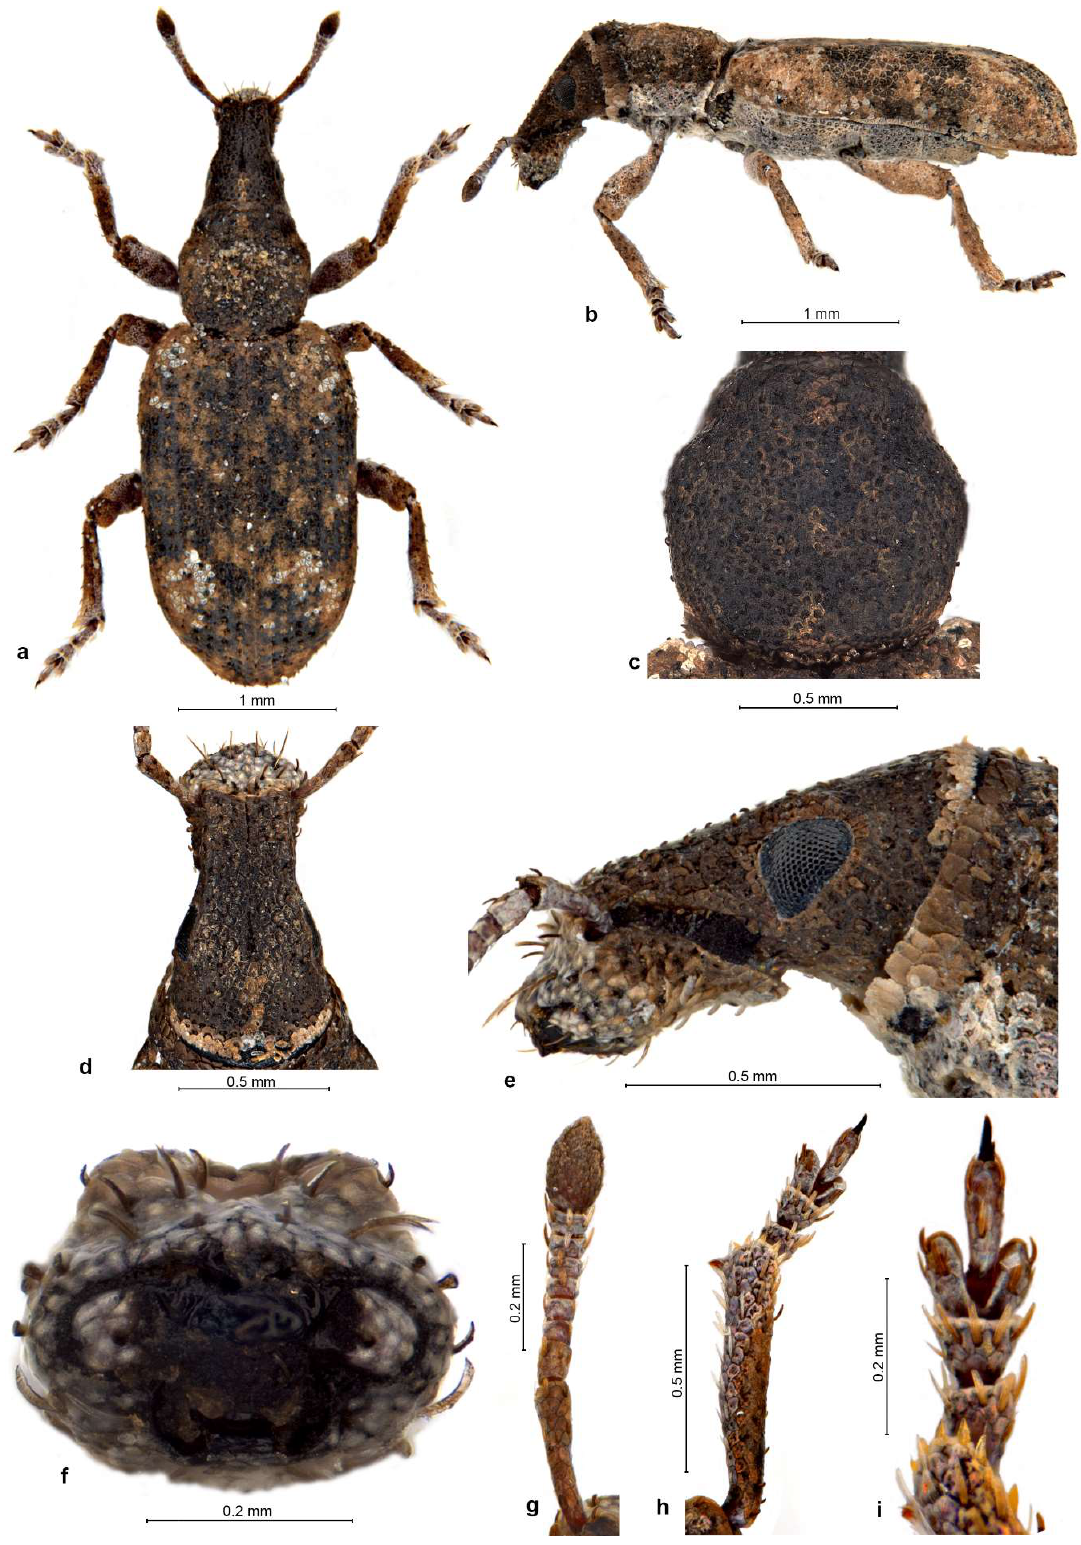
Figure 6. Philetaerobius endroedyi sp. n. ( Koeroegap), ♂ —dorsal habitus ( a ); left lateral habitus ( b ); pronotum, dorsal view ( c ); head, dorsal view ( d ); head, lateral view ( e ); rostrum and mandibles, frontal view ( f ); right antenna, dorsal view ( g ); right protibia and -tarsus, dorsal view ( h ); right protarsus, lateral view ( i ).